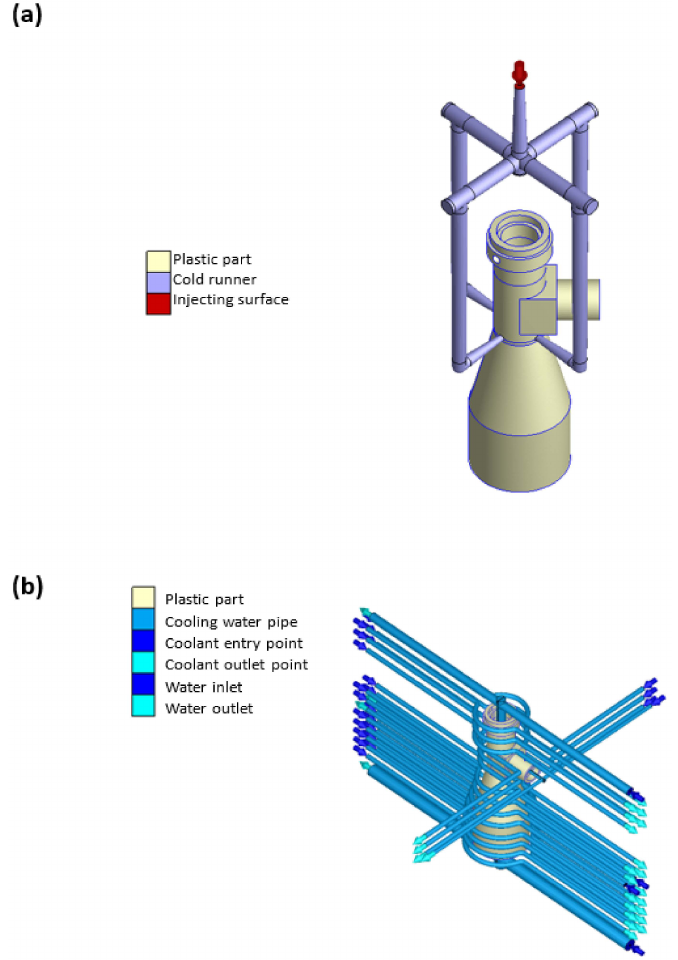
Figure 6. ( a ) Gating and ( b ) cooling systems for injection molding